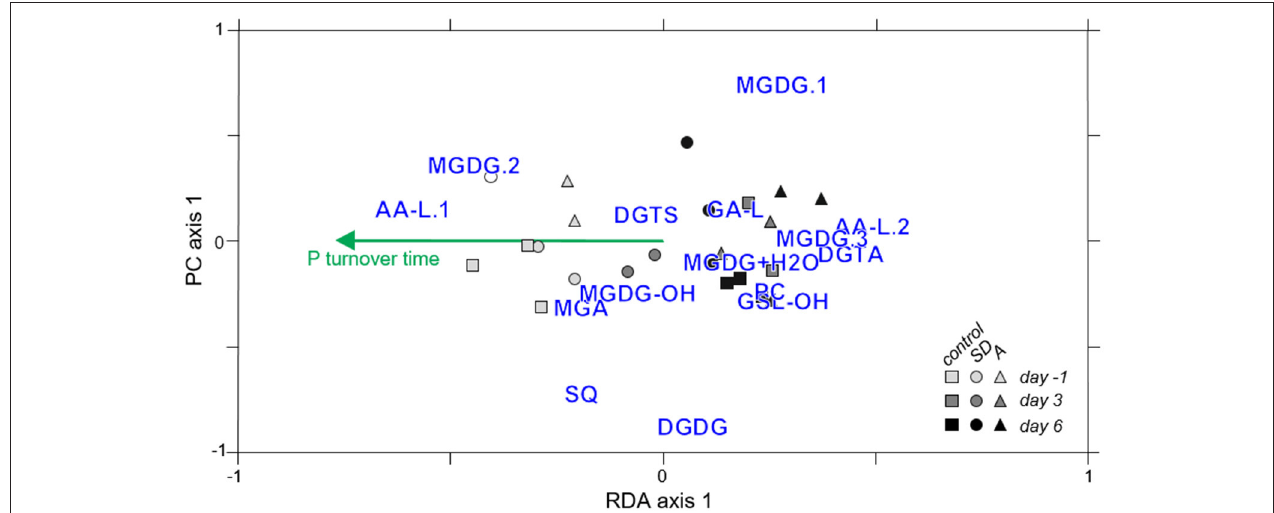
FIGURE 8 | Parsimonious RDA ( p = 0.001) showing groupings of samples collected from control (circles), Saharan dust (squares), and mixed aerosol (triangles) mesocosms on days -1 (light gray symbols), day 3 (dark gray symbols), or day 6 (black symbols) with IPL relative abundance (blue text) and the weighting of the environmental parameter that best explained lipid headgroup distributions (P turnover time, τ PO4 ,